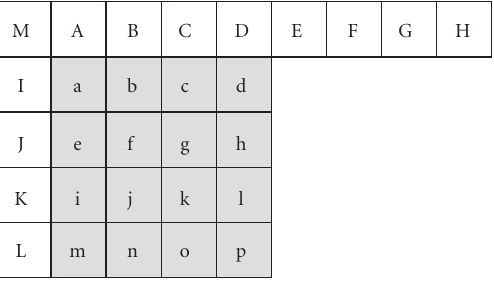
Figure 3: Neighbor samples used in the prediction of a 4 × 4